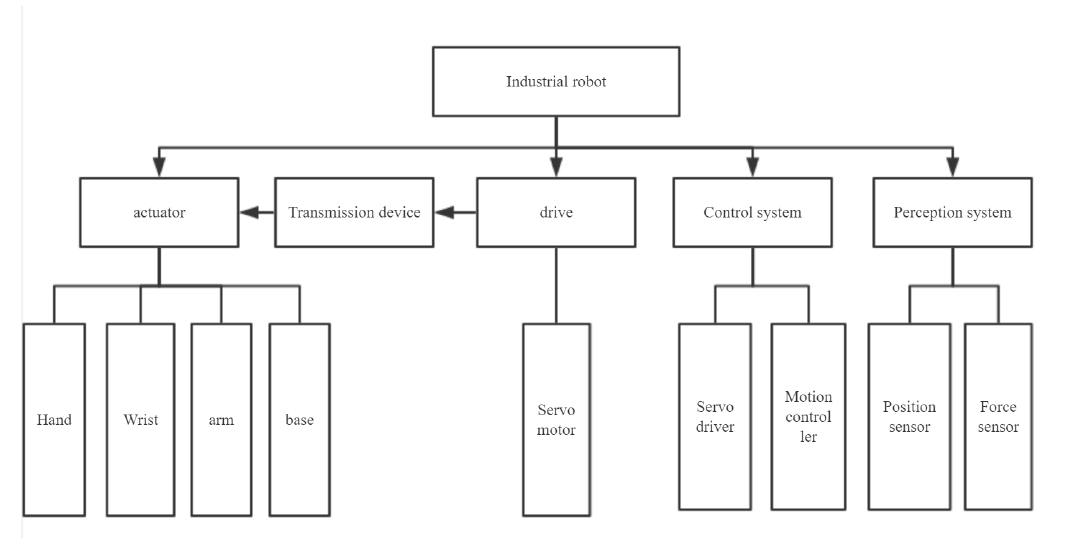
Fig. 1 Distribution of